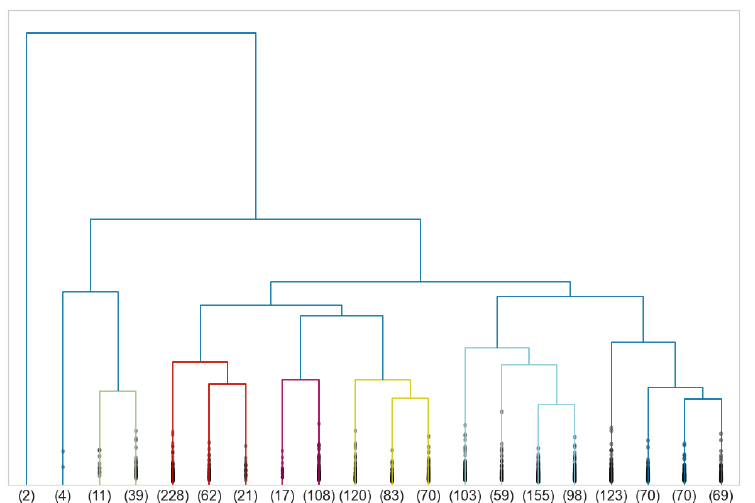
Figure 18. Dendrogram associated to a Ward-linkage hierarchical clustering of the silhouettes of the persistence diagrams of male point